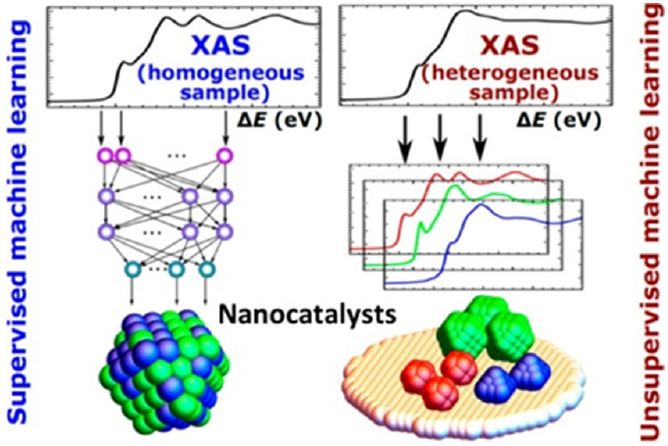
Figure 8. Schematic of supervised machine learning and unsupervised machine learning in catalysts [151] . Copyright 2019, ACS Publications.